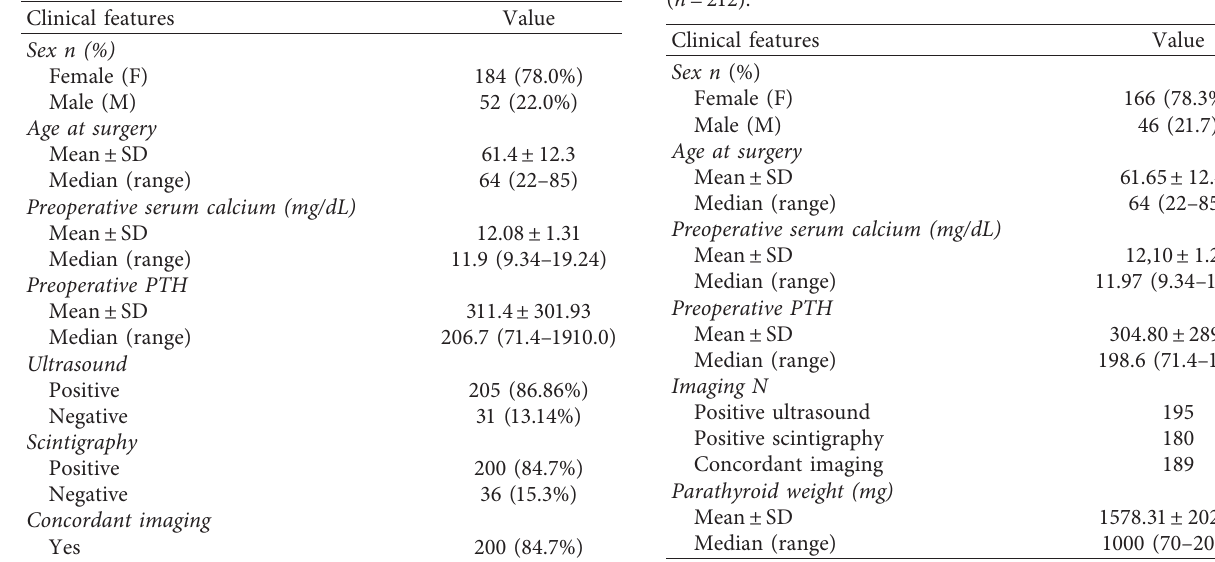
Table 3: Clinical features of patients with PHPT ( n � 286).